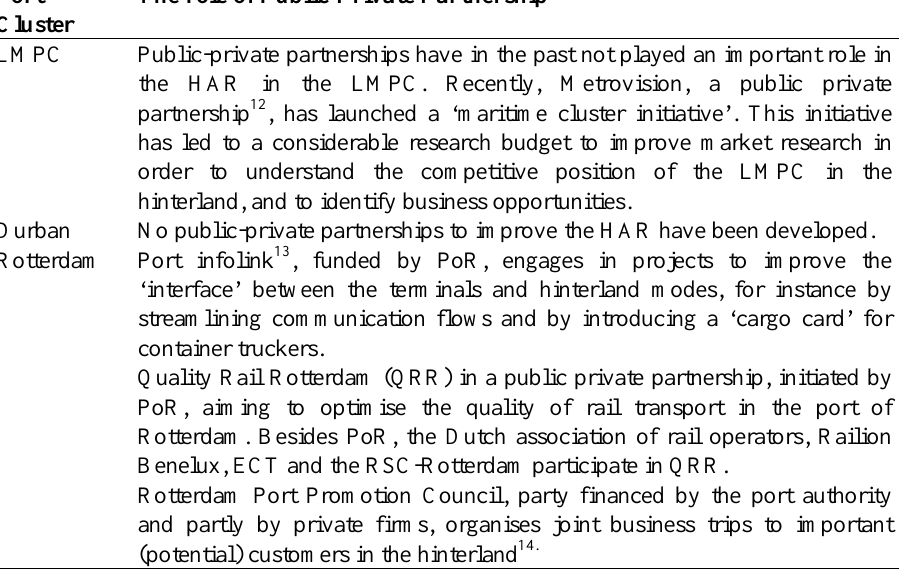
Table 11. The roles of public-private partnerships in the HAR’s